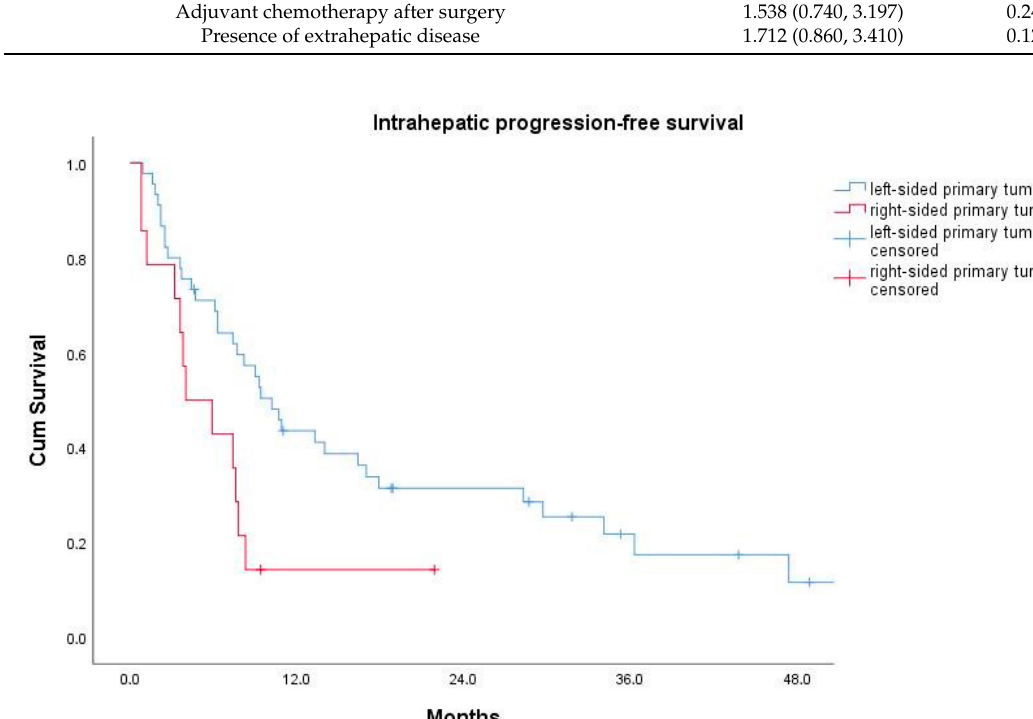
Figure 3. Kaplan – Meier curves for intrahepatic progression-free survival for patients with (red curve) and without (blue curve) liver metastases in the FLR before portal vein embolization .